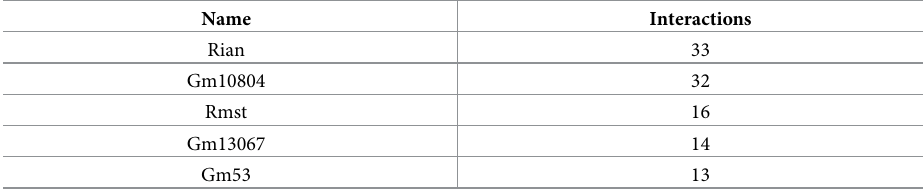
Table 1. Top 5 lncRNAs based on the number of interactions with